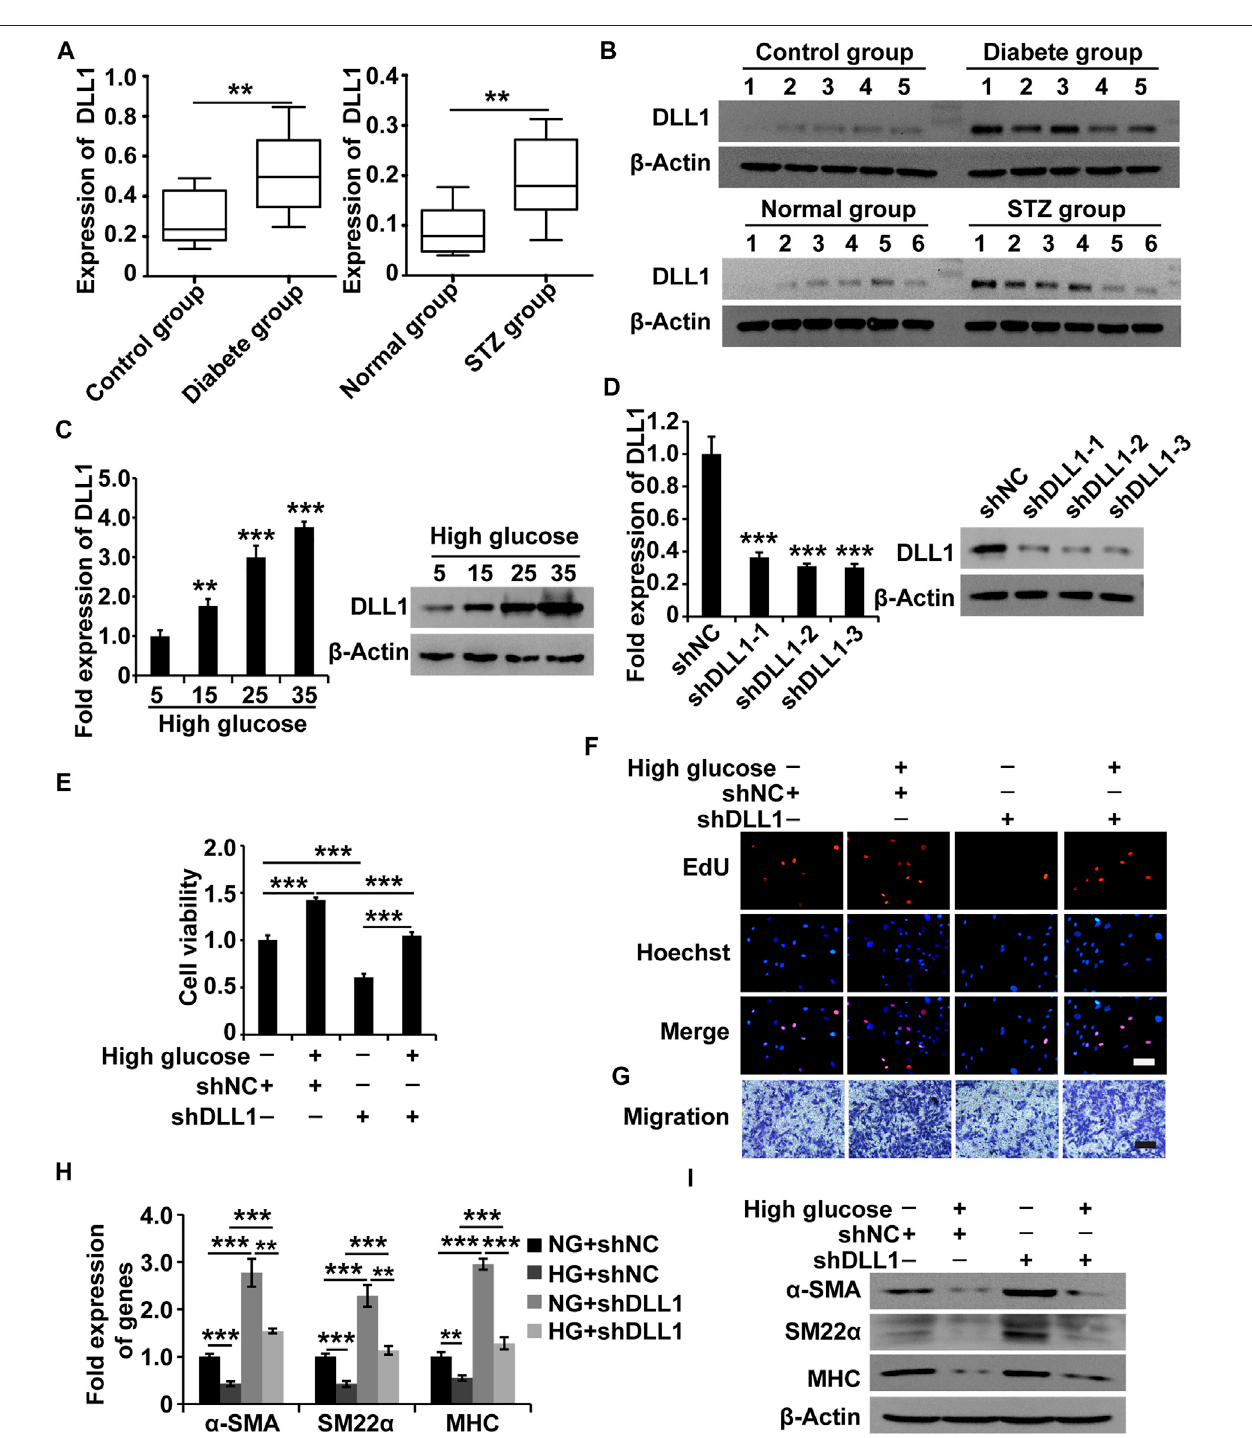
FIGURE 5 | DLL1 is a target of MALAT1 via miR-449a. (A) qPCR analysis of DLL1 expressions in the adjacent normal tissues from the stomach of patients who underwent gastrectomy with or without DM and DGP symptoms ( n (cid:1) 10 per group) as well as in the gastric tissues from DGP and control mice ( n (cid:1) 10 per group). (B) Western blot analysis shows that the expression levels of DLL1 proteins were signi fi cantly upregulated in the gastric tissues of DGP clinical samples and DGP model mice. (C) qPCR and western blot analyses of the expression of DLL1 in HGSMCs treated with different concentrations of glucose (5, 15, 25, and 35 mM) for 48 h. (D) qPCRandwesternblotanalysesoftheexpressionofDLL1inHGSMCstransfectedwithshDLL1sandshNC. (E – G) CCK8,EdU,andTranswellassaystoanalyzethe viability, proliferation, and migration of HGSMCs under different treatments. (H – I) qPCR and western blot analyses of SMC contractile markers ( α -SMA, SM22 α , and MHC)inHGSMCsunderdifferenttreatments.For (E – I) fourgroupswereanalyzed:NG+shNCgroup,HG+shNCgroup,NG+shDLL1group,andHG+shDLL1group. β -Actin was used as an internal control. *** p < 0.001, ** p < 0.01, * p < 0.05.